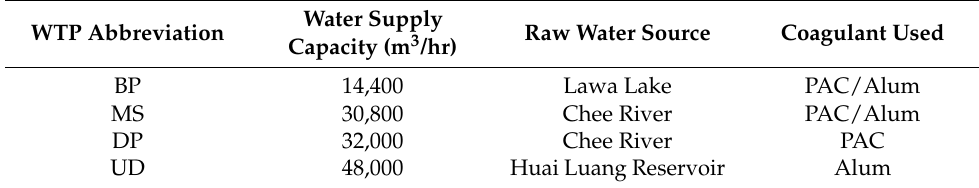
Table 1. Characteristics of water treatment plants (WTPs) from which DWTR was sampled.